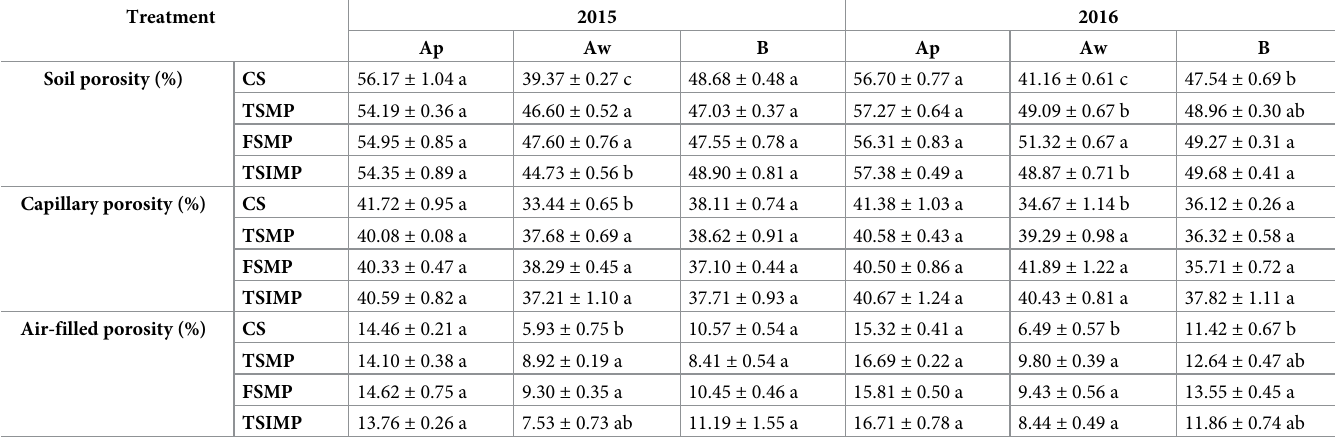
Table 2. Effects of soil mixing on the soil characteristics of Albic soil. Treatment